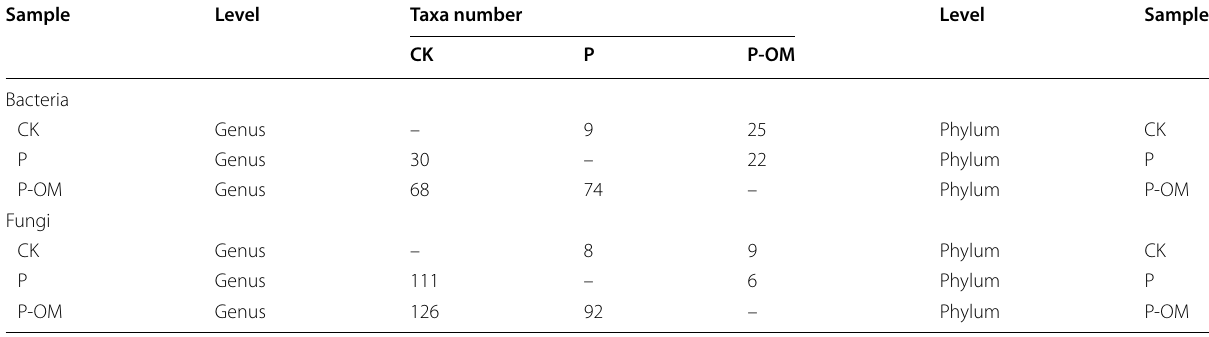
Table 3 Summary of Metastats paired comparison in phylum and genus level with the significance thresholds P < 0.05